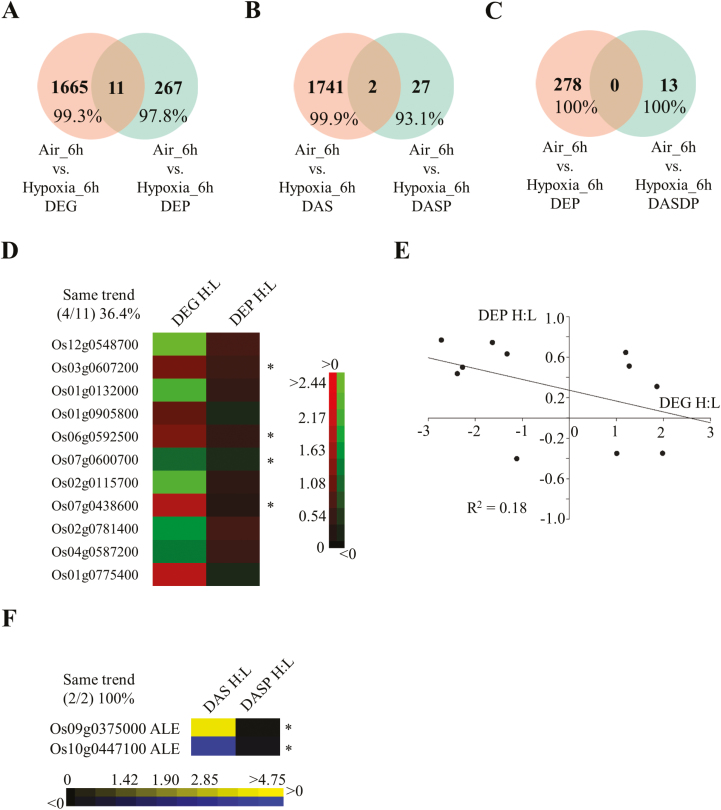
Comparison between proteomic and transcriptomic data sets. Venn diagram representation of (A) differentially expressed genes (DEGs) versus differentially expressed proteins (DEPs), (B) differentially expressed AS (DAS) events versus differentially expressed AS peptides (DASDPs), (C) DEPs versus DASDPs. Heatmap representation (D) and correlation analysis (E) of overlapping genes between DEGs and DEPs. (F) Heatmap representation of overlapping genes between DASs and DASDPs. ALE, alternative last exon; an asterisk represents the regulation of transcripts and proteins with the same trend in corresponding data sets; H:L, hypoxia versus air control.